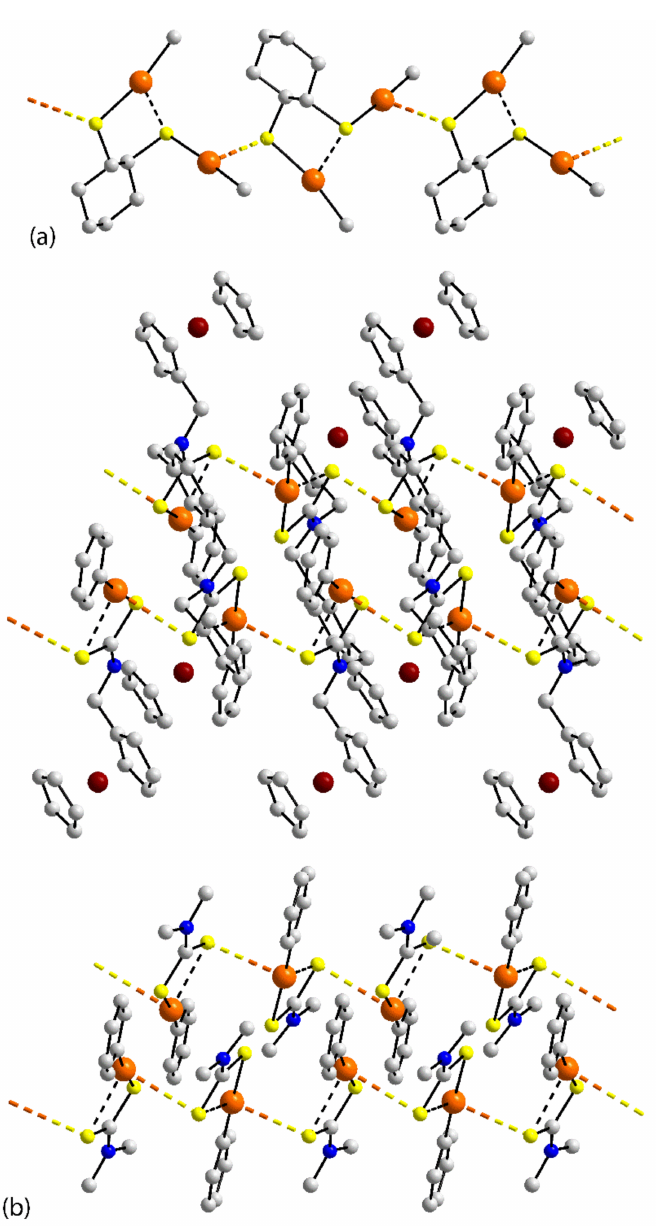
Figure 20. Supramolecular association in the crystals with chains having a helical topology: ( a ) di- nuclear 53 and ( b ) di-nuclear 55 with the lower view showing only the carbon atoms directly bonded to nitrogen so the links between the chains are